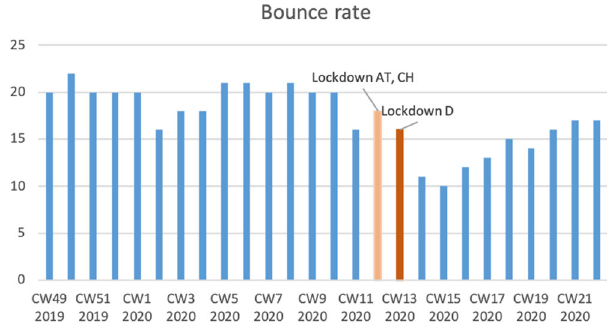
Fig. 3 Bounce rate during the investigation (average per week). A signi fi cant decrease can be seen after the beginning of the lockdown (Austria (AT), Switzerland (CH) = pink; Germany (D) = orange). CW = Calendar